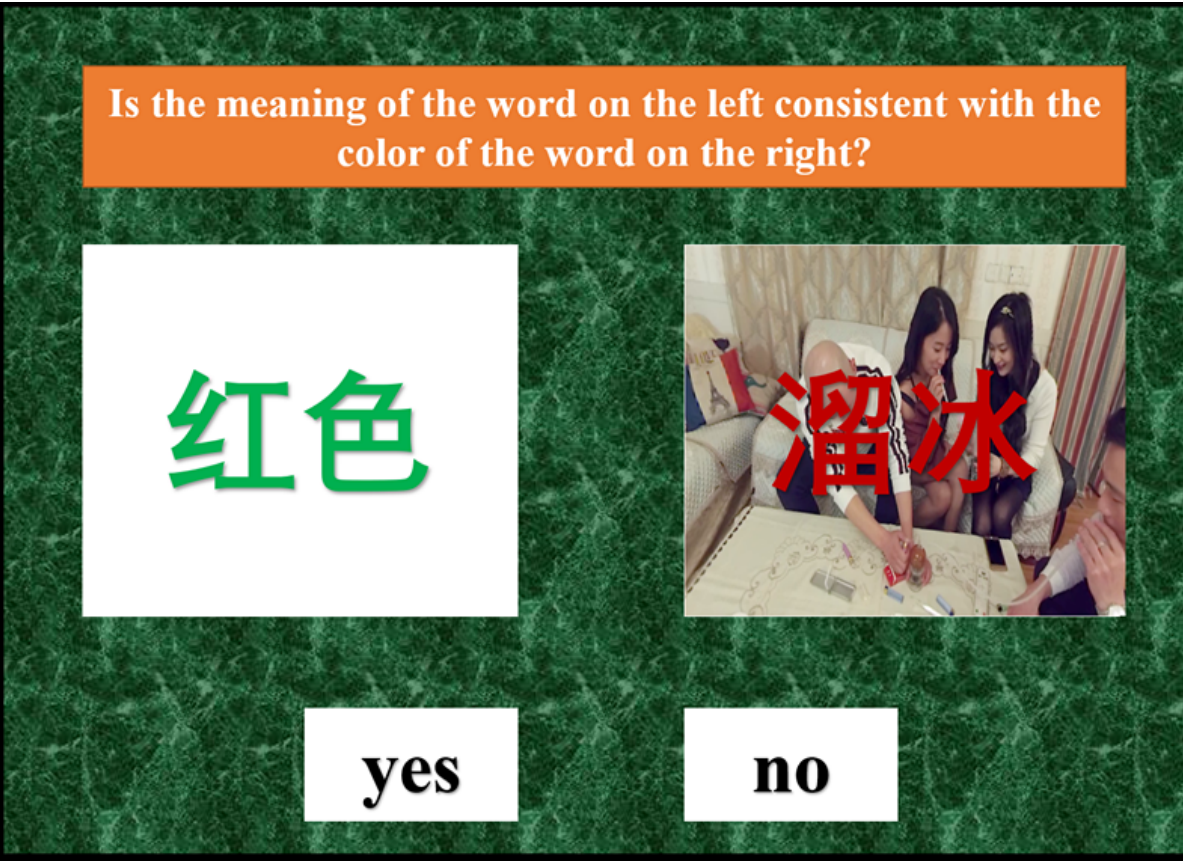
Figure 1. Methamphetamine-related attention bias modification task. Patients were asked to decide whether the meaning of the word in the left box was consistent with the color of the word on the right. The Chinese word printed in green on the left means “red,” whereas the phrase presented on the right means “smoking